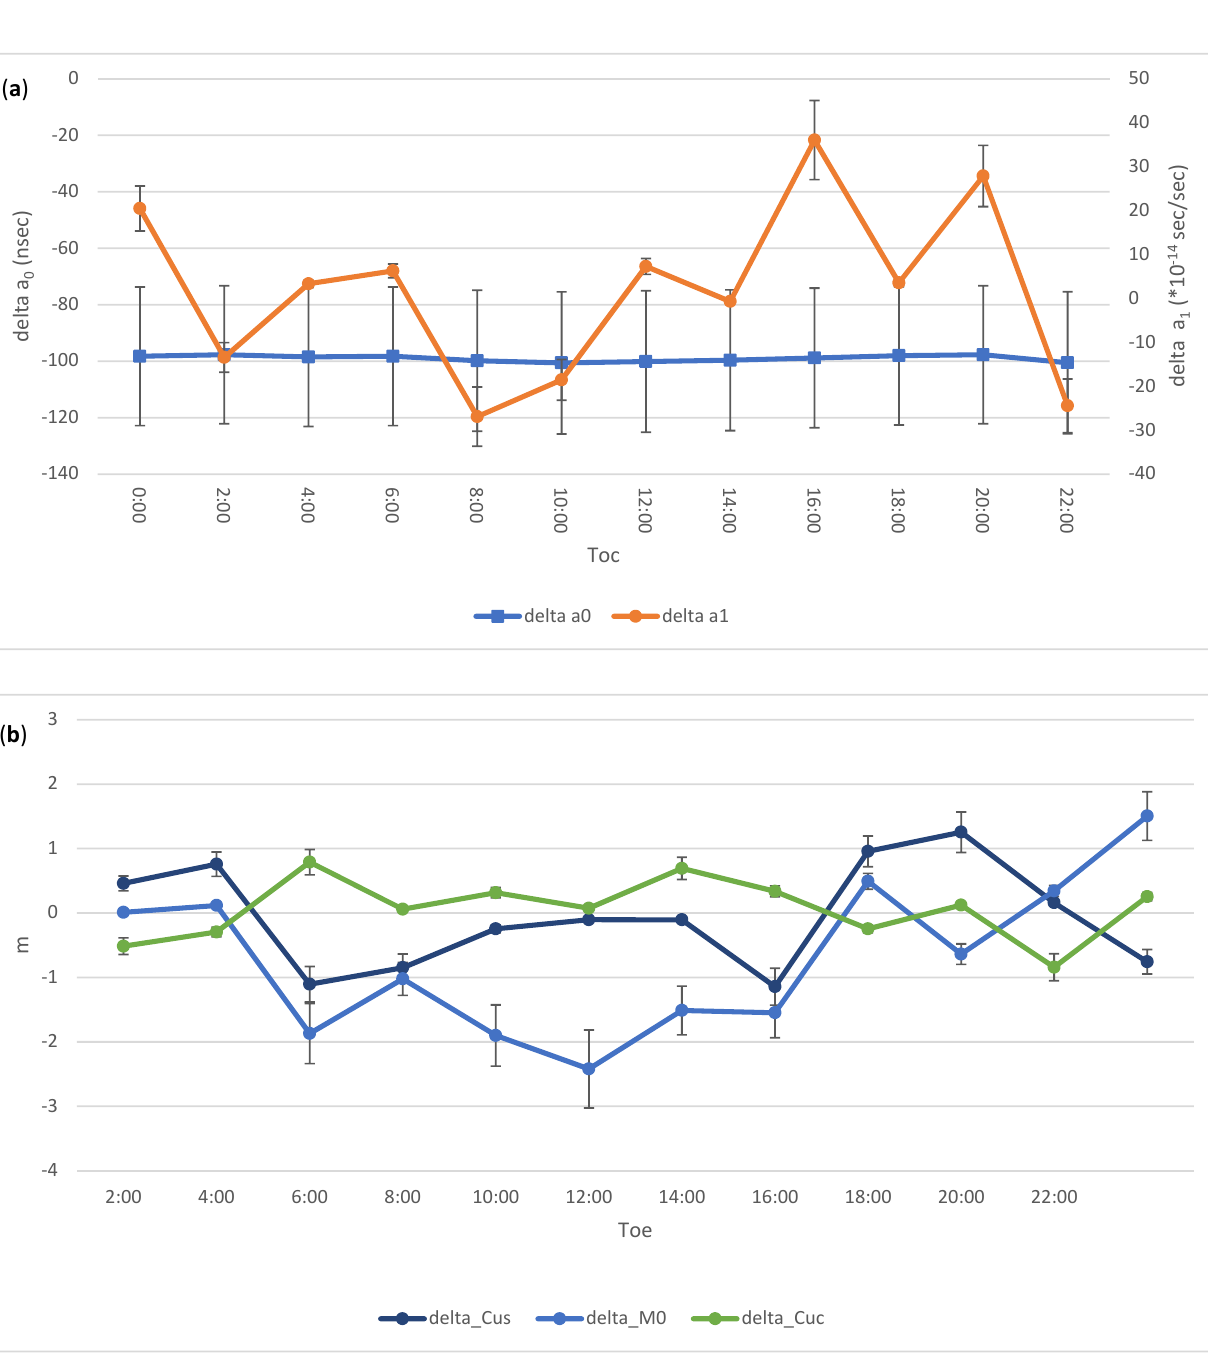
poral coordinates. The large bias in the pre-fit residuals is primarily due to the clock offset of the broadcast message relative to the SP3 values, equivalent to nearly 30 m or 10 − 7 s (Figure 7a). The rms of the post-fit residuals is dominated by the spatial component: the clock polynomials fit with a typical rms of 0.002 m, about a factor of eight smaller than the rms of the spatial components.